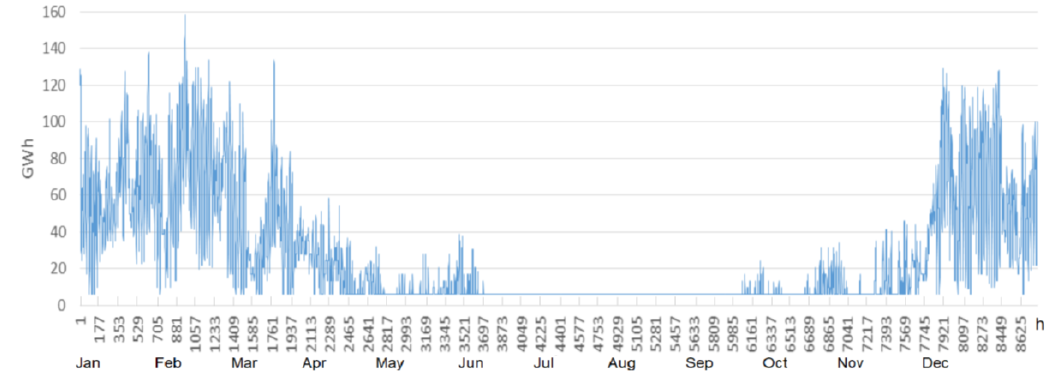
Figure 3. Hourly heat demand distribution in Italy.